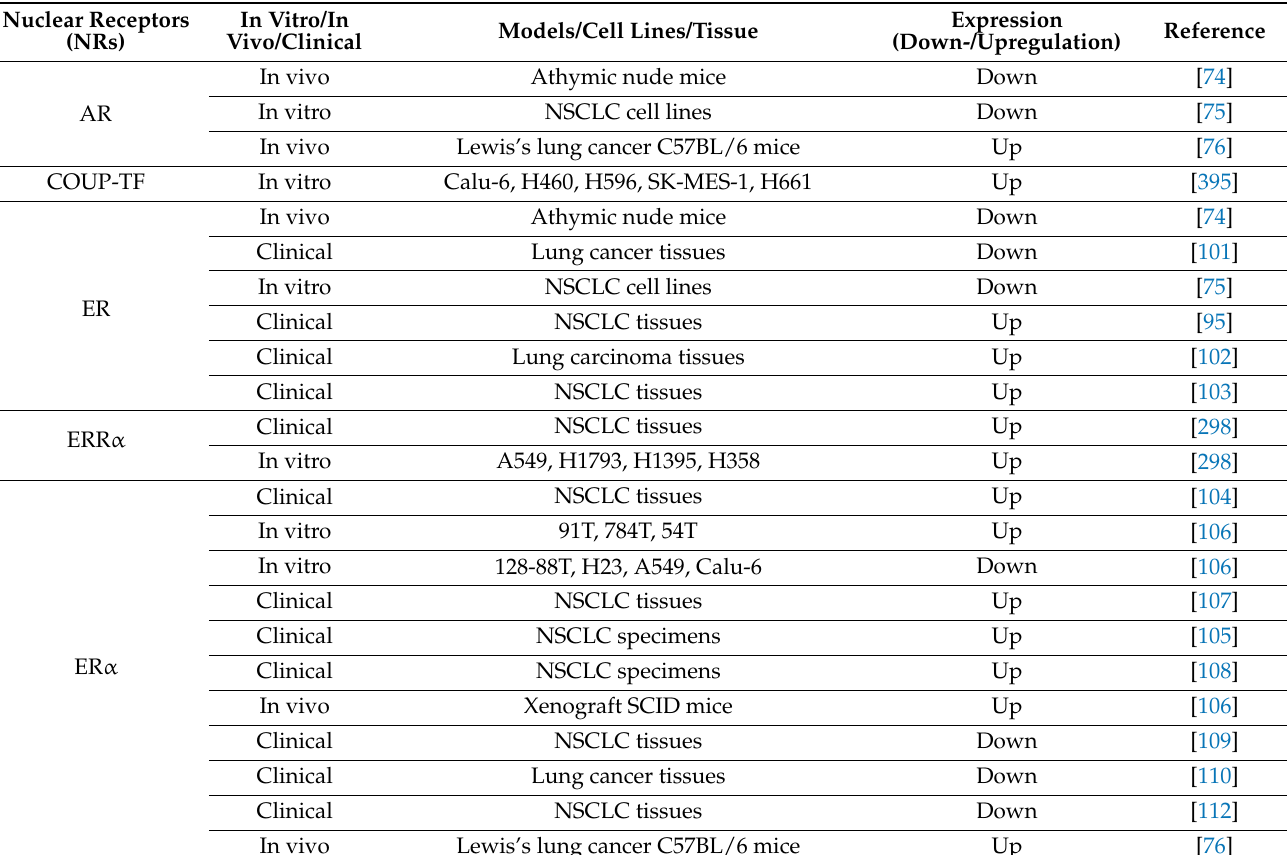
Table 1. Nuclear receptor (NR) expression in lung cancer tissues and cell